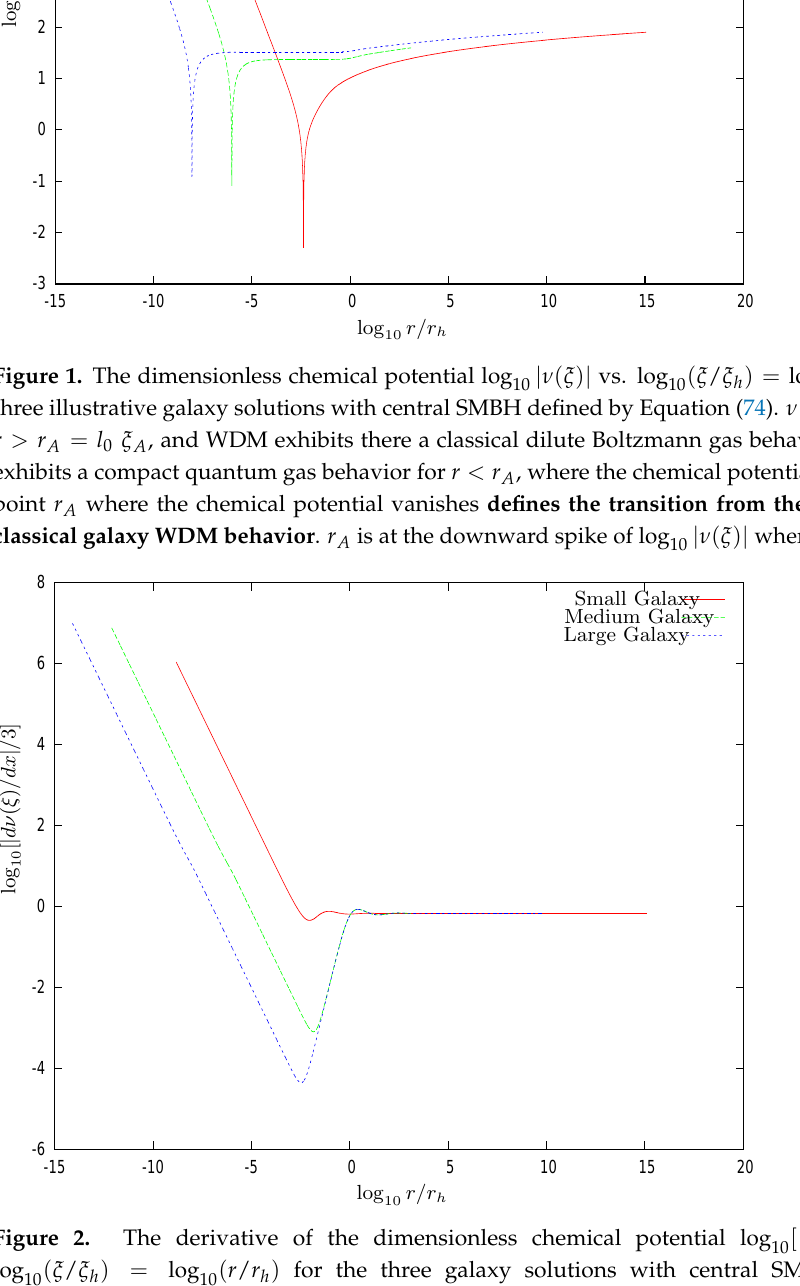
FIG. 2: The derivative of the dimensionless chemical potential log galaxy solutions with central SMBHs defined by eq.(3.7). For r . r i both ν ( ξ ) and the central black hole. r i is the influence radius of the BH defined by eq. (2.21). For r & r i , ν ( ξ ) and